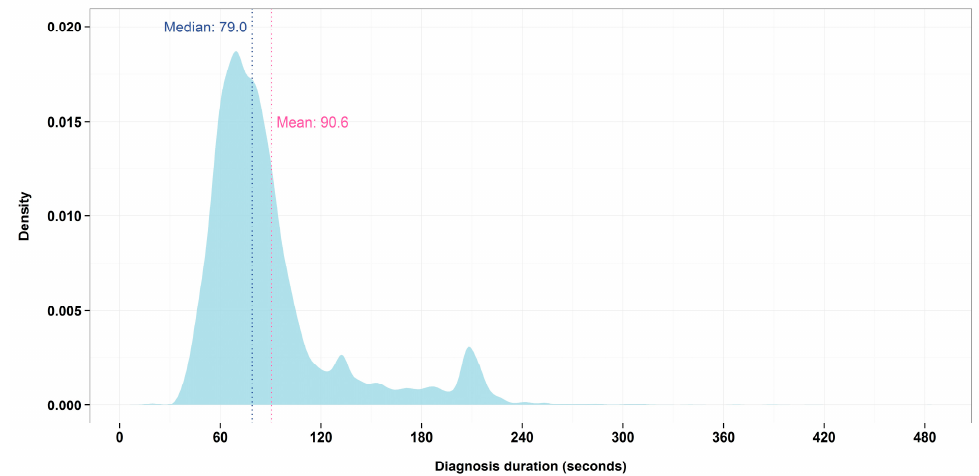
Figure 8. Fault root cause clusters.